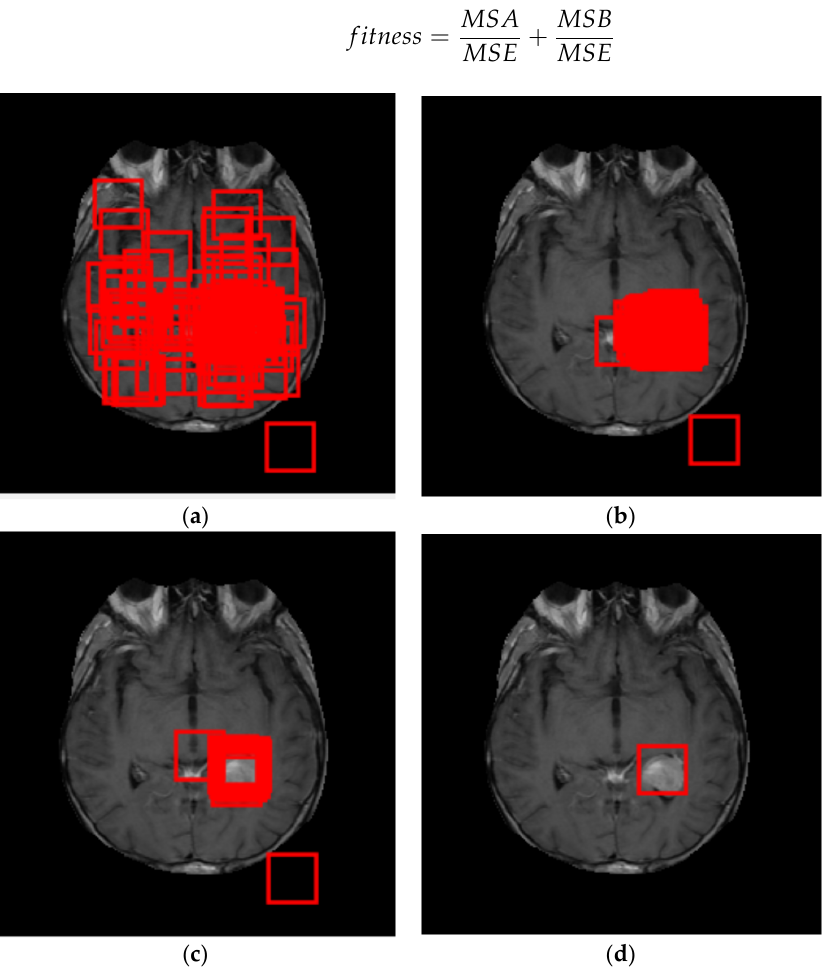
Figure 10. ROI identification, using PSO and ANOVA: ( a ) candidate blocks (in red) after 5 iterations; ( b ) candidate blocks after 15 iterations; ( c ) candidate blocks after 35 iterations; ( d ) candidate blocks after 50 iterations.